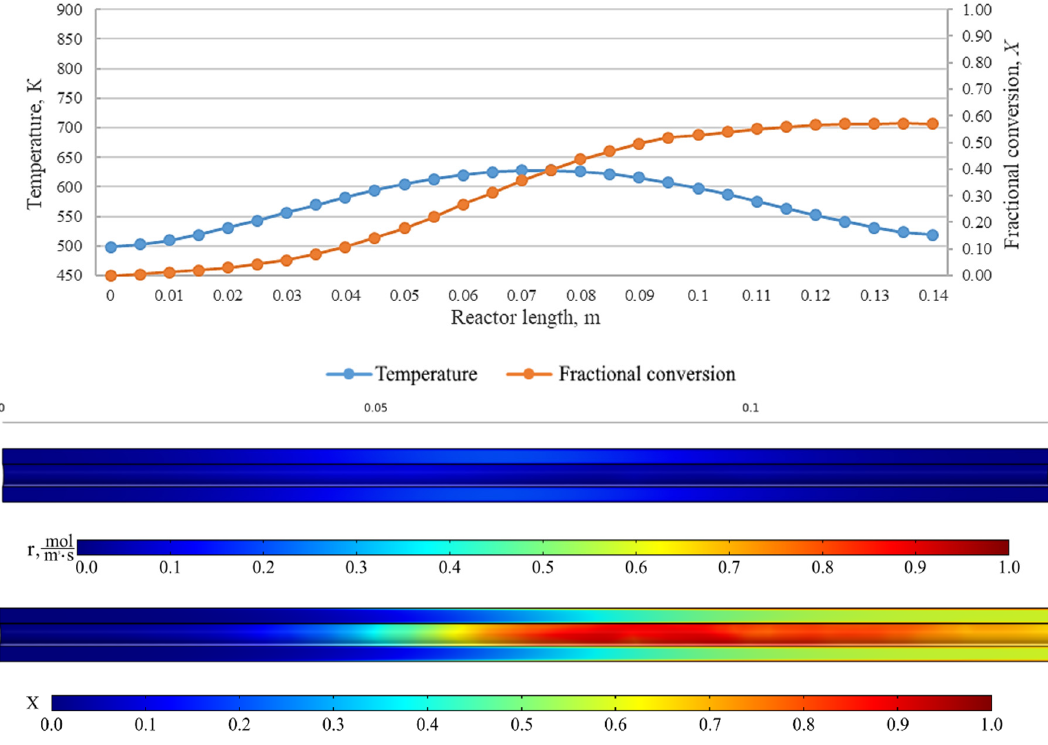
Figure 8. From top to bottom: temperature and fractional conversion curves, profiles of the reaction rate and fractional conversion along the reactor length for the experiment BnOm_350_18 (Tmax = 350 °С , 𝑉(cid:4662) = 0.05 L/min).